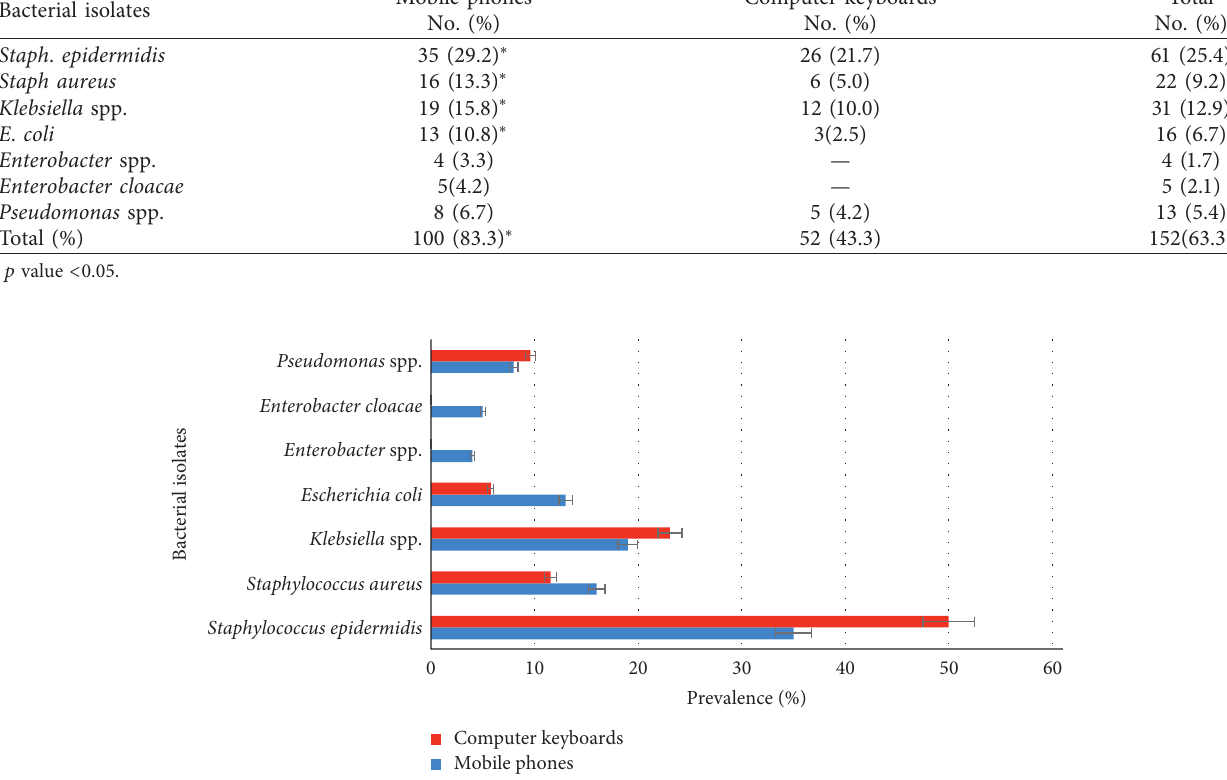
Figure 1: Prevalence of bacteria isolated from mobile phones and computer keyboards. Table 2: Distribution of bacteria isolates amongst study areas.